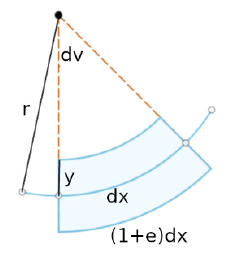
Figure 8. Elementary section of the beam.